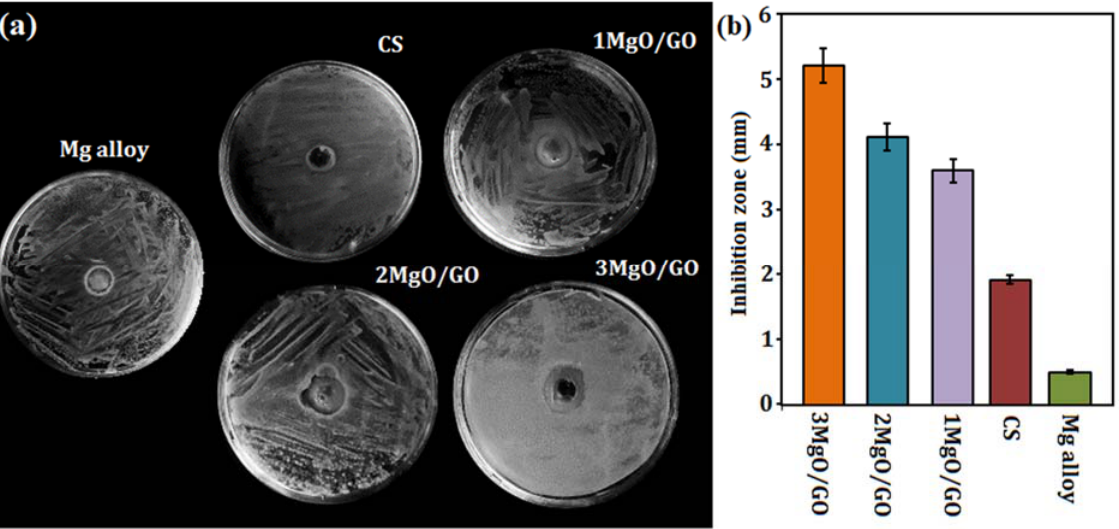
Figure 10. ( a ) Images of inhibition zones, and ( b ) values of growth ‐ inhibition zones of uncoated Mg alloy, CS, CS/1MgO ‐ GO, CS/2MgO ‐ GO, and CS/3MgO ‐ GO coated Mg samples after 24